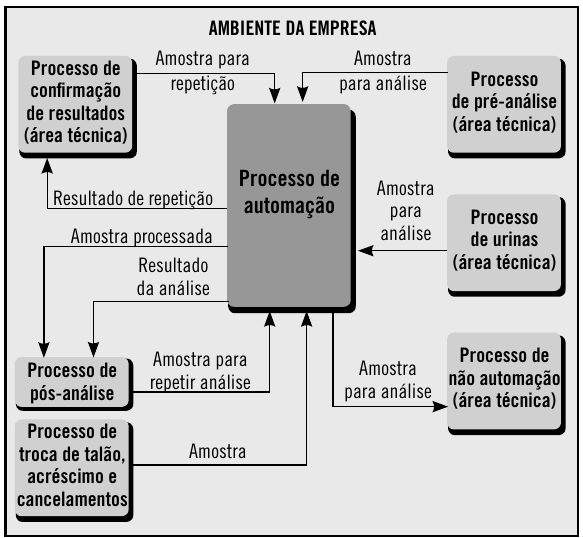
Figura 2 – Exemplo de diagrama de